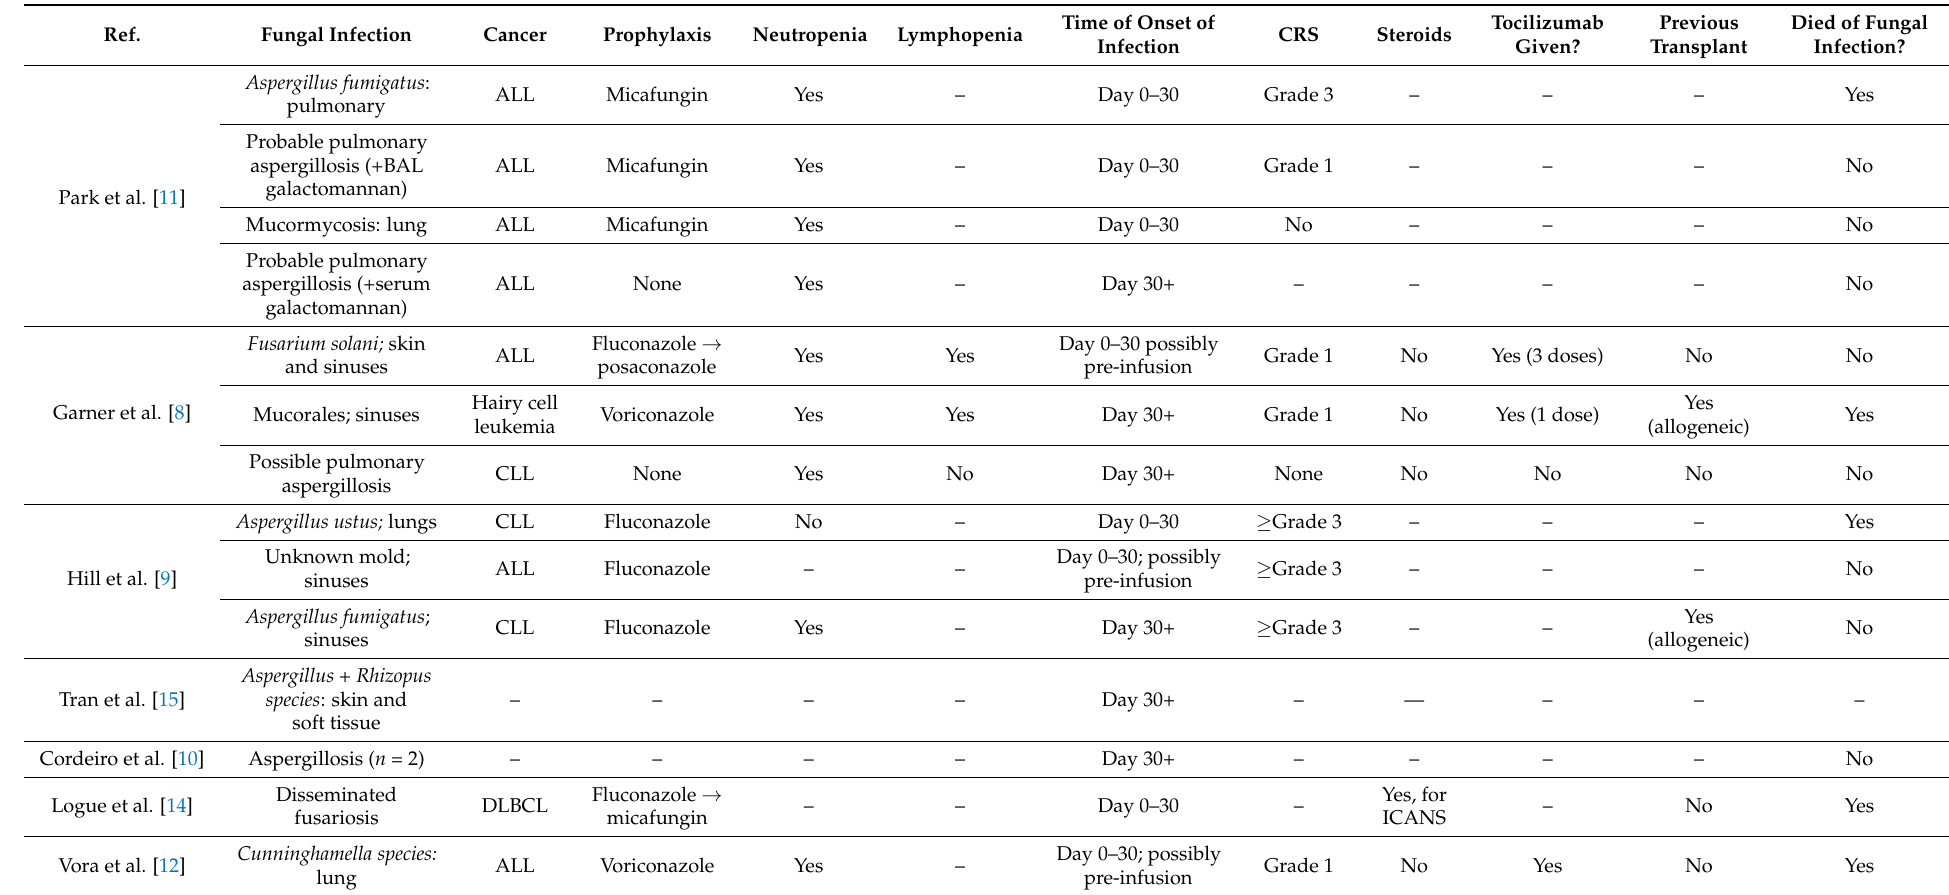
Table 2. Published reports of invasive mold infections following CAR-T-cell therapy. Neutropenia defined as absolute neutrophil count <500 cells/ µ L. Lymphopenia defined as absolute lymphocyte count <1000 cells/ µ L. ALL = acute lymphoblastic leukemia; BAL = bronchoalveolar lavage; CLL = chronic lymphocytic leukemia; CRS = cytokine release syndrome; DLBCL = diffuse large B-cell lymphoma; ICANS = immune effector cell-associated neurotoxicity syndrome. Dashes indicate that the data were not reported in the studies.